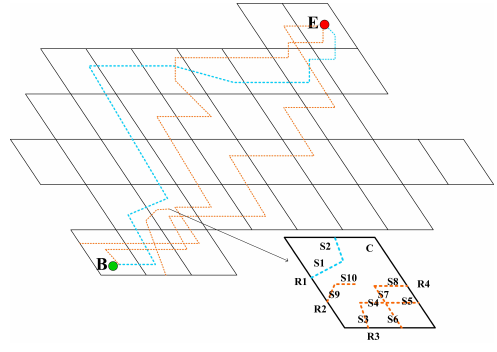
Figure 1. The model